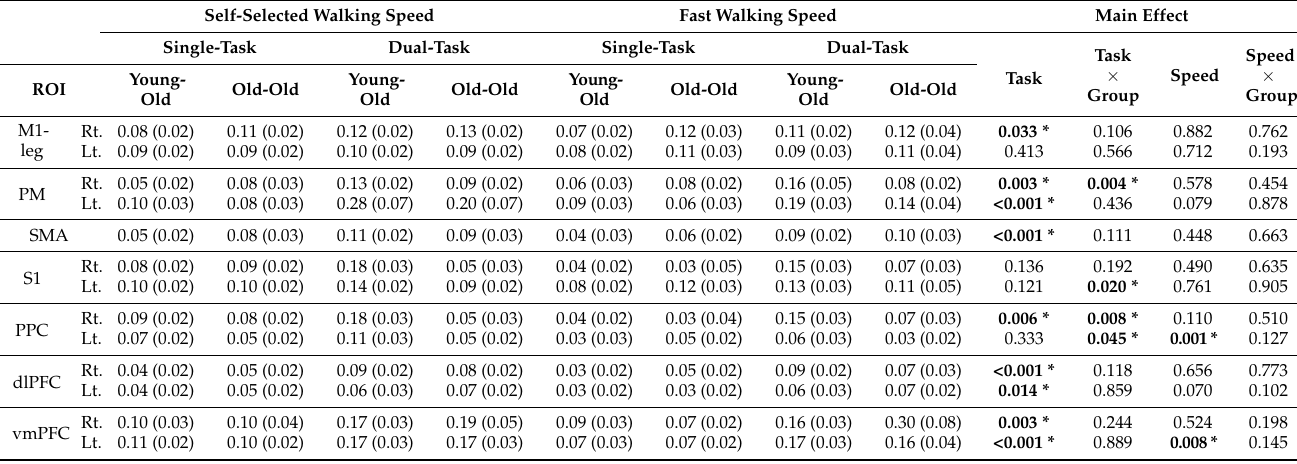
Table 3. Changes in the integral values of oxyhemoglobin by walking condition in each ROI. Self-Selected Walking Speed Fast Walking Speed Main Effect